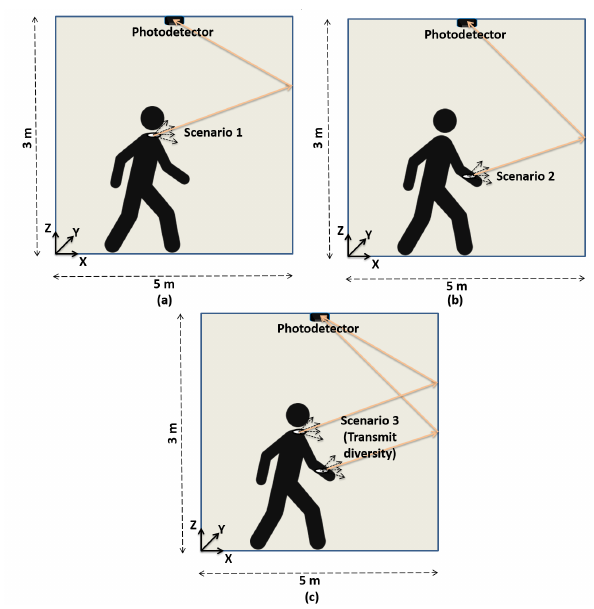
Figure 3. Mobility support with the coordinator placed on the body and the receiver on the